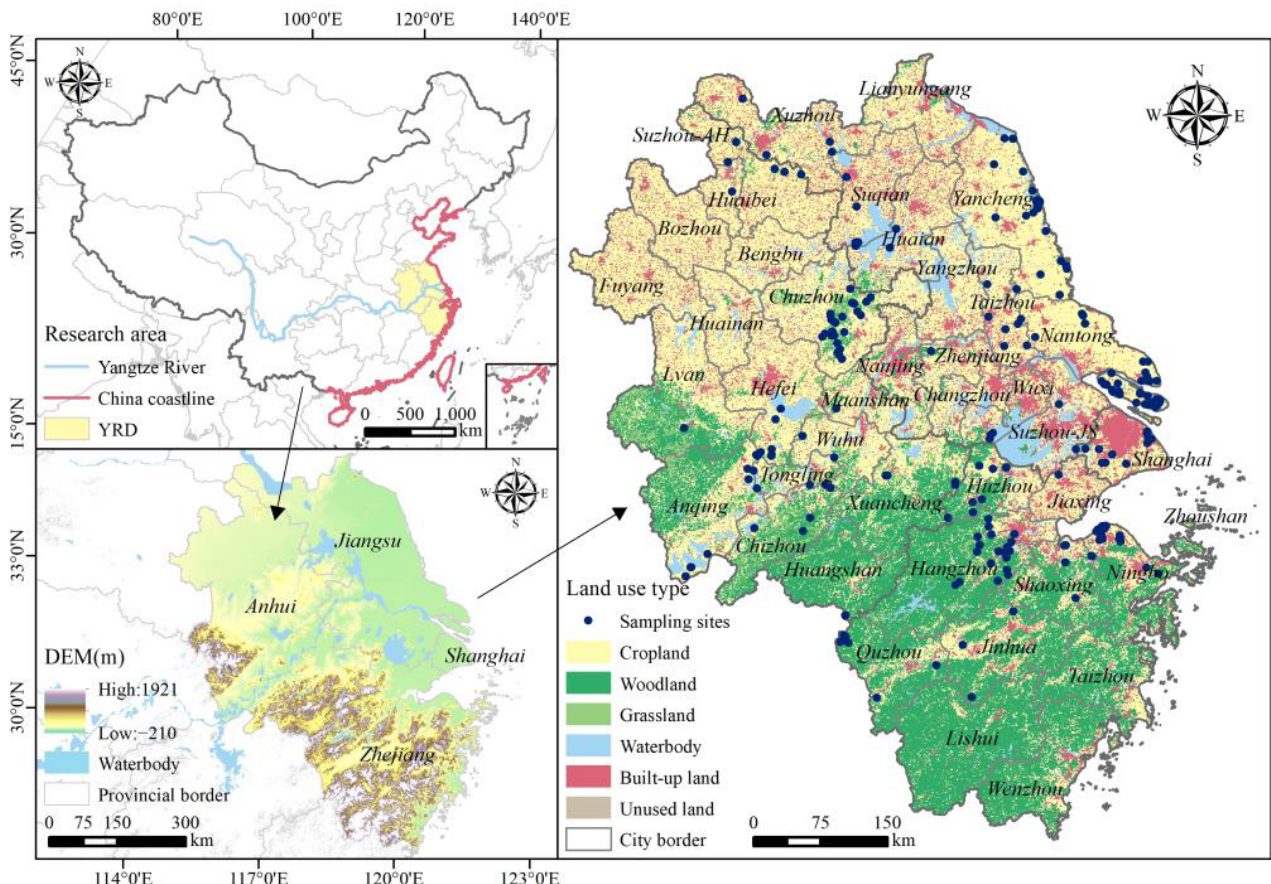
Figure 1. Location, DEM, and land use map of YRD.